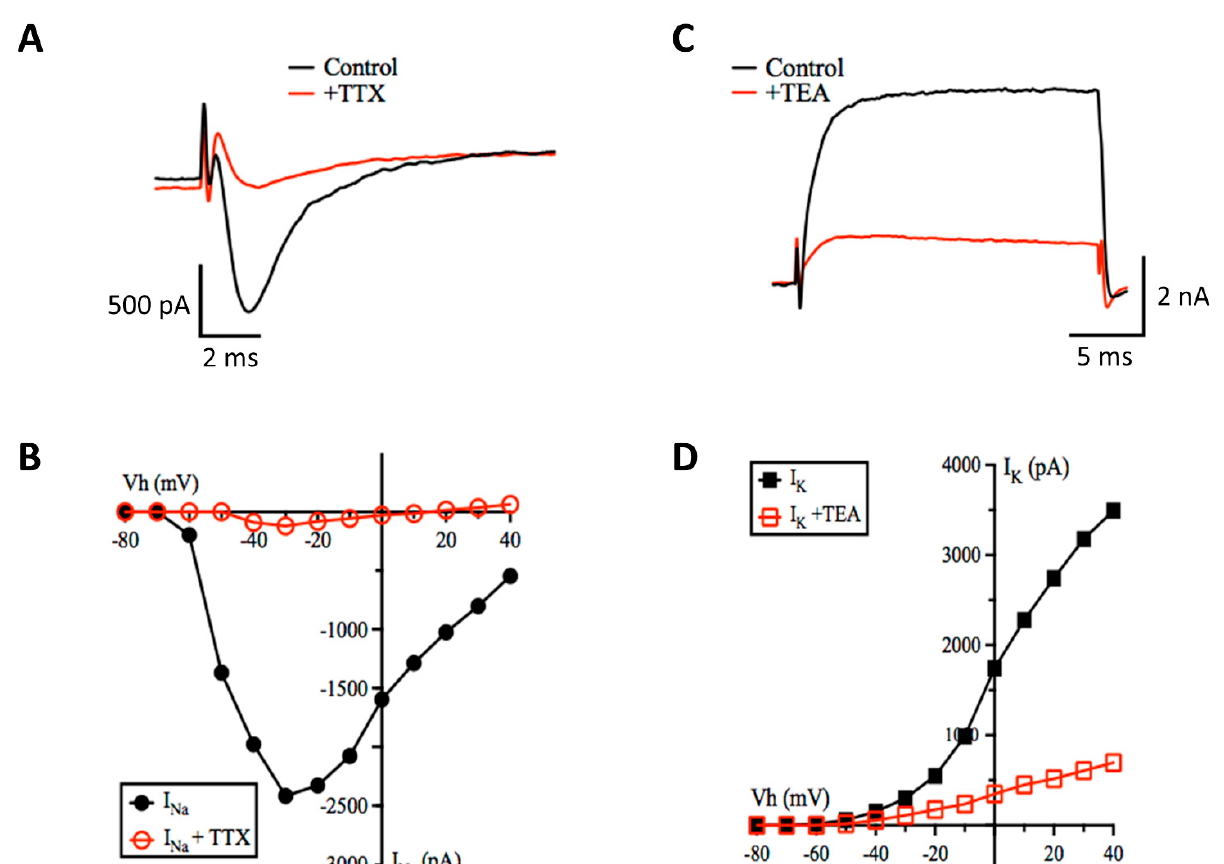
Figure 5. iCell neurons show robust voltage-activated currents. ( A ) whole-cell (sodium) currents evoked by a step from − 80 to − 40 mV (black trace) that was inhibited by TTX (100 nM, red trace). ( B ) plot of the peak inward currents against voltage steps from − 80 to +40 mV in the absence ( ● black line) and presence ( ○ red line ) of TTX (100 nM). ( C ) whole-cell (potassium) current evoked by a step from − 80 to +40 mV (black trace) was inhibited by TEA (5 mM, red trace). ( D ) plot of the peak inward currents against voltage step in the absence ( ▪ black line) and presence ( □ red line) of TEA (5 mM).